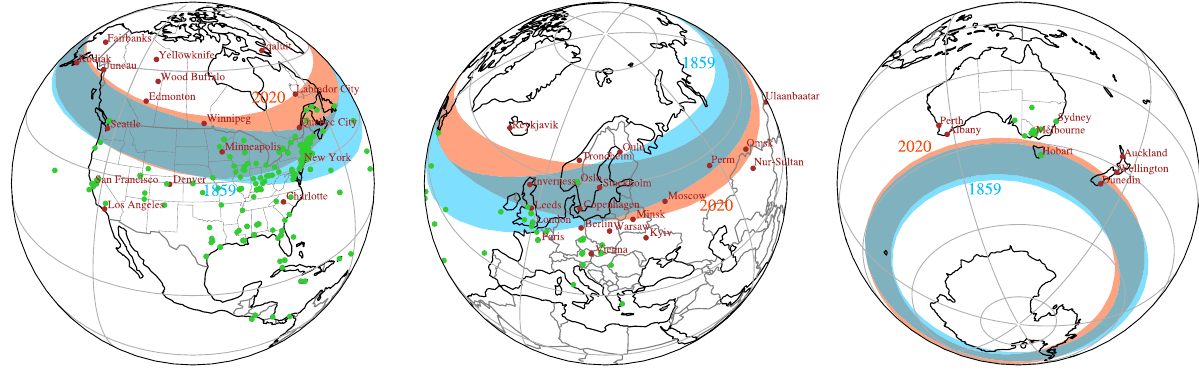
Figure 2. High-exposure regions to severe space weather events (‘danger zones’) for 2020 and 1859, the year of the Carrington Event. 50 ◦ -to- 60 ◦ AACGM latitudinal bands for 2020 (the orange bands) and 1859 (the cyan bands), shown via a near-side projection. The geomagnetic field for 1859 and 2020 is described by the coefficients of the gufm1 and IGRF-13 models, respectivley. Locations of selected cities inside or in the proximity of the danger zones are also reported. The green dots indicate sightings of auroral activity reported between 28th of August and 4th of September, 1859 25 . These maps were generated in Python 3.8 with the library cartopy (version